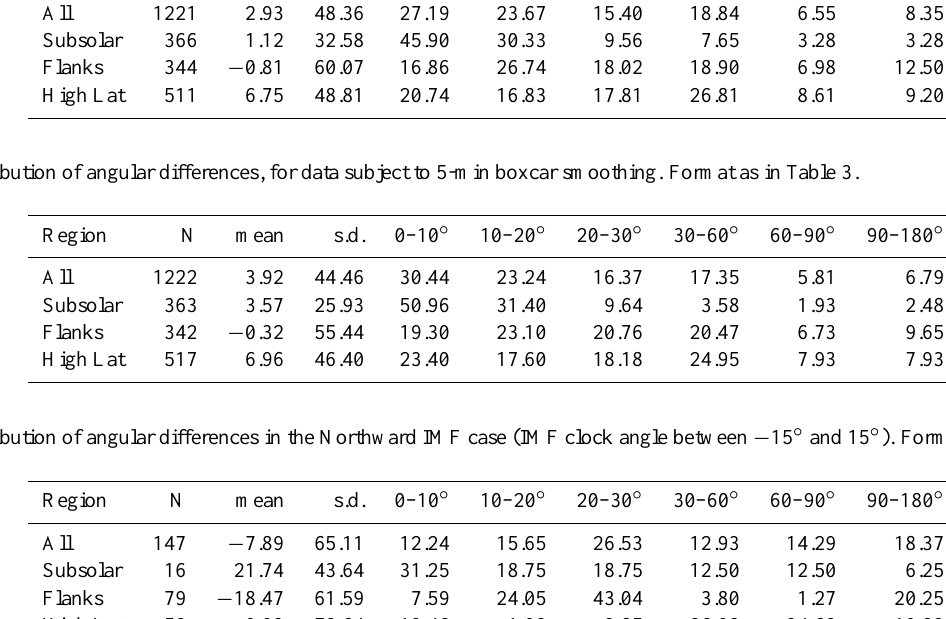
Table 3. Distribution of absolute angular differences between the clock angle of the magnetosheath field measured within 2 R E of the magnetopause and the time-shifted IMF clock angle. The subsolar region is defined by | y | < 5 R E and | z | < 5 R E , the high-latitude regions, defined by | z |≥ 5 R E , and the equatorial flanks, defined by | y |≥ 5 R E and | z | < 5 R E . N is the total number of points in the magnetopause- crossing data. The mean and standard deviation of the angular difference are shown in the columns “mean” and “s.d.”, and the last six columns show the percentage of data points in each of six ranges of angular difference.